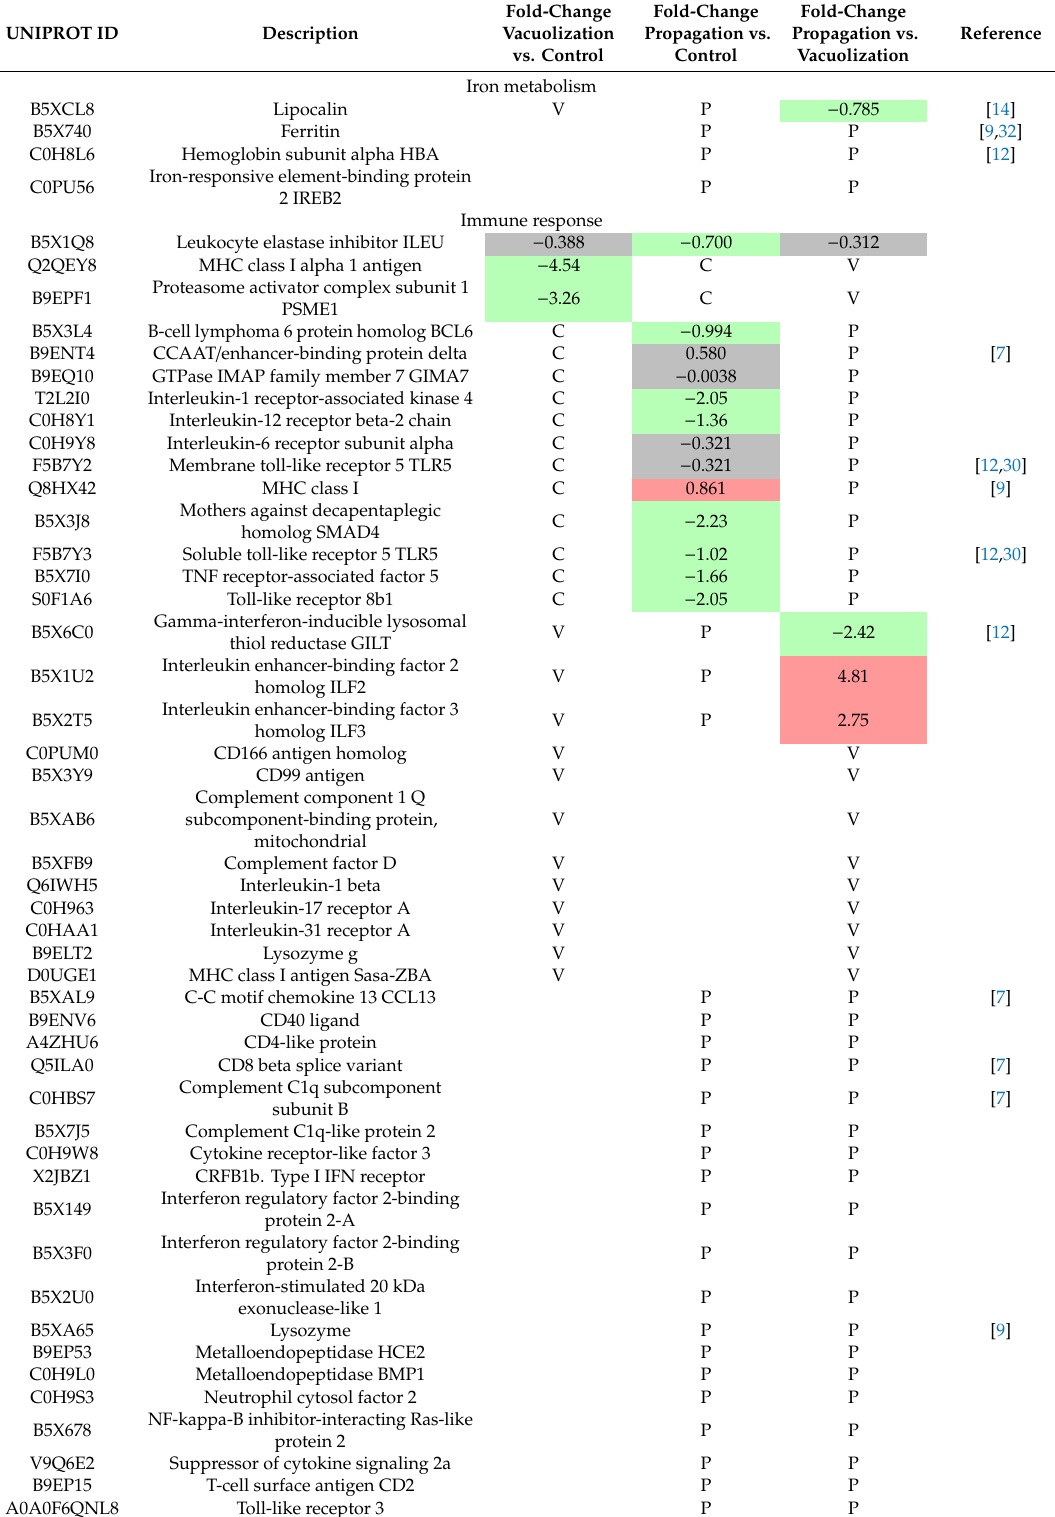
Table 1. List of S. salar proteins identified by quantitative proteomics and classified in protein categories. SHK-1 proteins were identified (UNIPROT id) and quantified in uninfected cells (control sample), SHK-1 cells infected with P. salmonis in vacuolization stage, and in propagation stage. Significantly upregulated proteins (log 2 ratio ≥ 0.6) are colored red, downregulated proteins (log 2 ratio ≤ − 0.6) in green, and unchanged in gray. “C” indicates the protein was found only in control sample, “V” only in vacuolization sample, and “P” only in propagation sample. The reference column indicates if a protein was found and reported